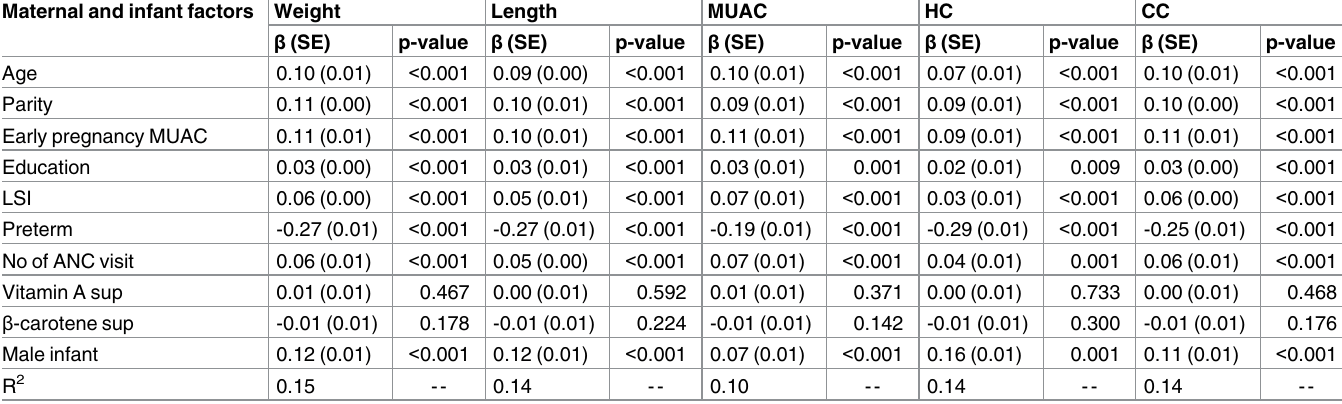
Abbreviations: SE, Standard Error; MUAC, Mid-Upper Arm Circumference; LSI, Living Standard Index; Mom MUAC, Maternal Mid-Upper Arm